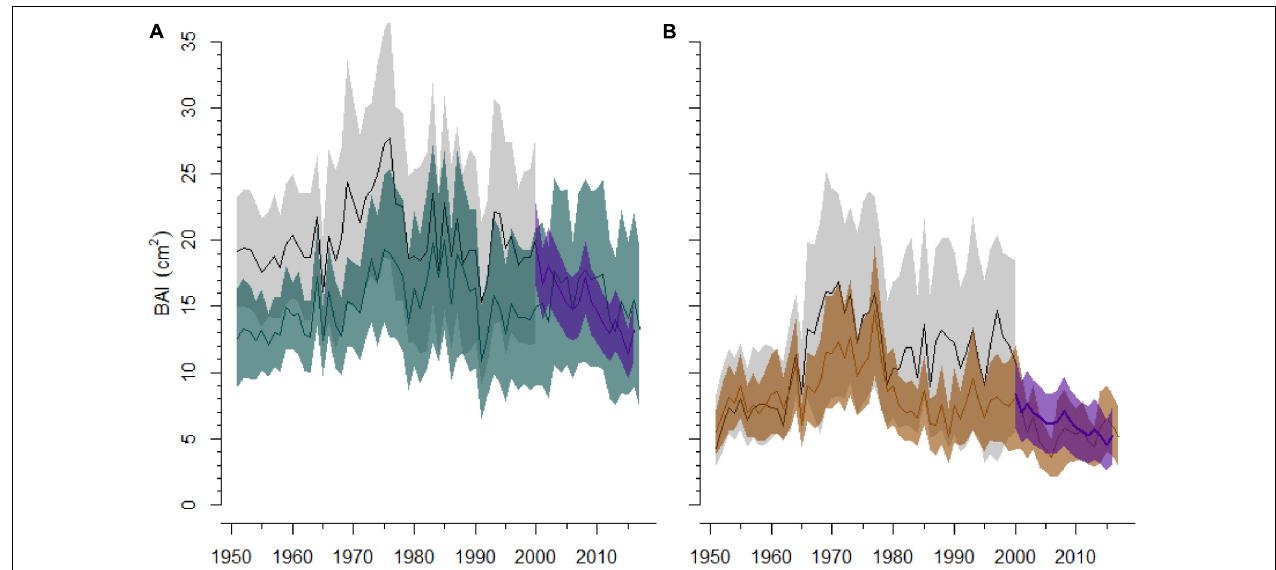
FIGURE 5 | Past and present growth (BAI, basal area increment) trajectories in a non-declining ( A , site BA) Silver fir site and a showing dieback ( B , site CA). Black lines and gray areas represent the mean BAI and its 95% confidence intervals (CIs), respectively, for the trees sampled in 1999–2000. Blue and brown lines and corresponding shaded areas represent the mean BAI and 95% CIs of the trees sampled in 2019, in the non-declining and the silver fir stand showing dieback respectively. The purple line and dashed area represents the mean of the projected BAI (and 95% CIs) according to the generalized additive mixed effect